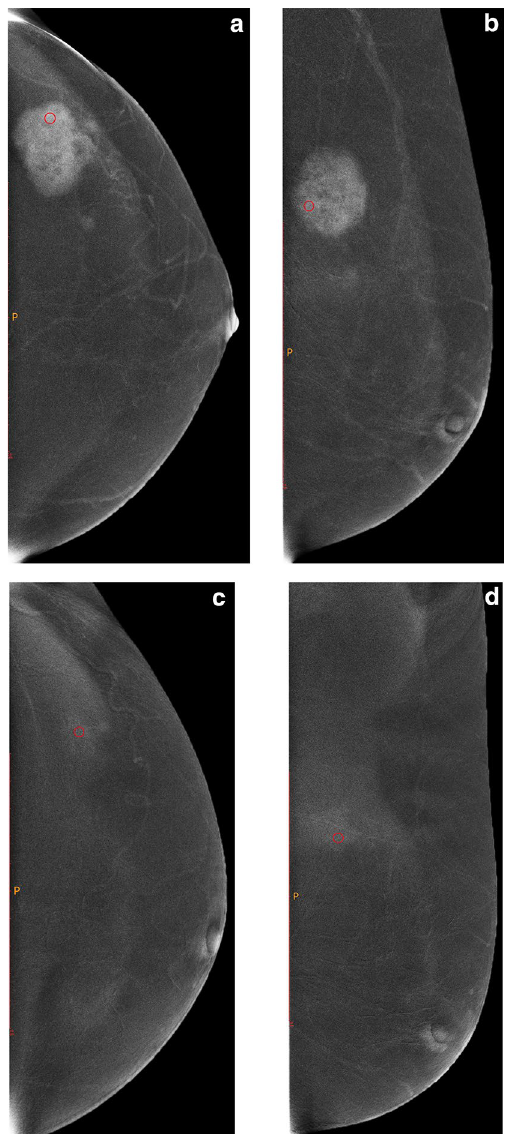
Figure 1. Female, 51 years old, with lesion located in the outer upper quadrant of the left breast. (a,b) are the subtraction images of CC and MLO views of CESM before NAC, and (c,d) are the subtraction images of CC and MLO views of CESM after two cycles of NAC, respectively. The CC and MLO view grey value reduction percentages were 40.27% and 16.13%, respectively. Before surgery, core needle biopsy confirmed that the patient had invasive breast cancer. After surgical resection, the pathological results showed no invasive cancer components with MP Grade